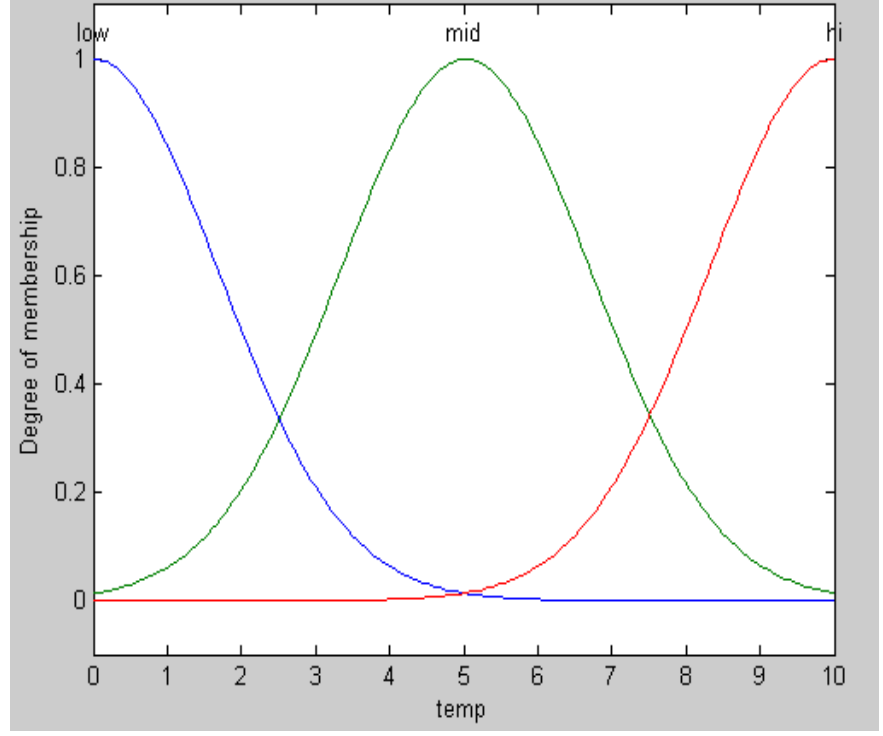
Figure 5. Temperature measured on the road surface.